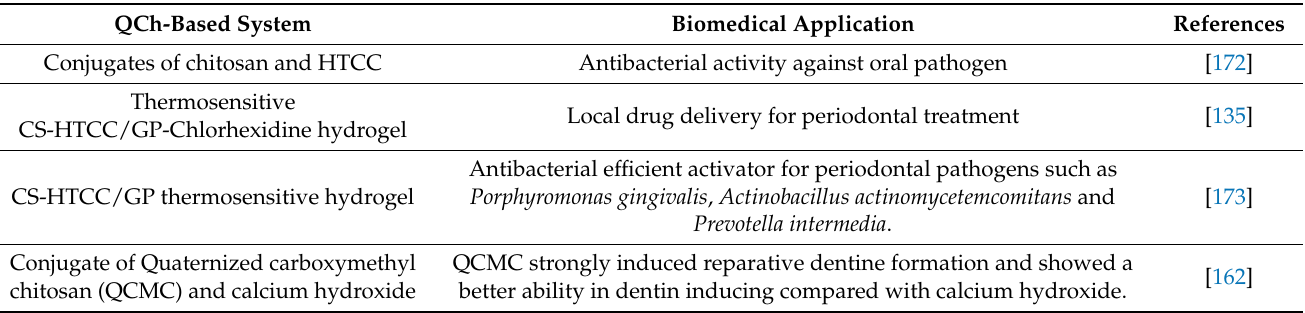
Table 6. Research highlights few dental/cosmetic uses of QCh